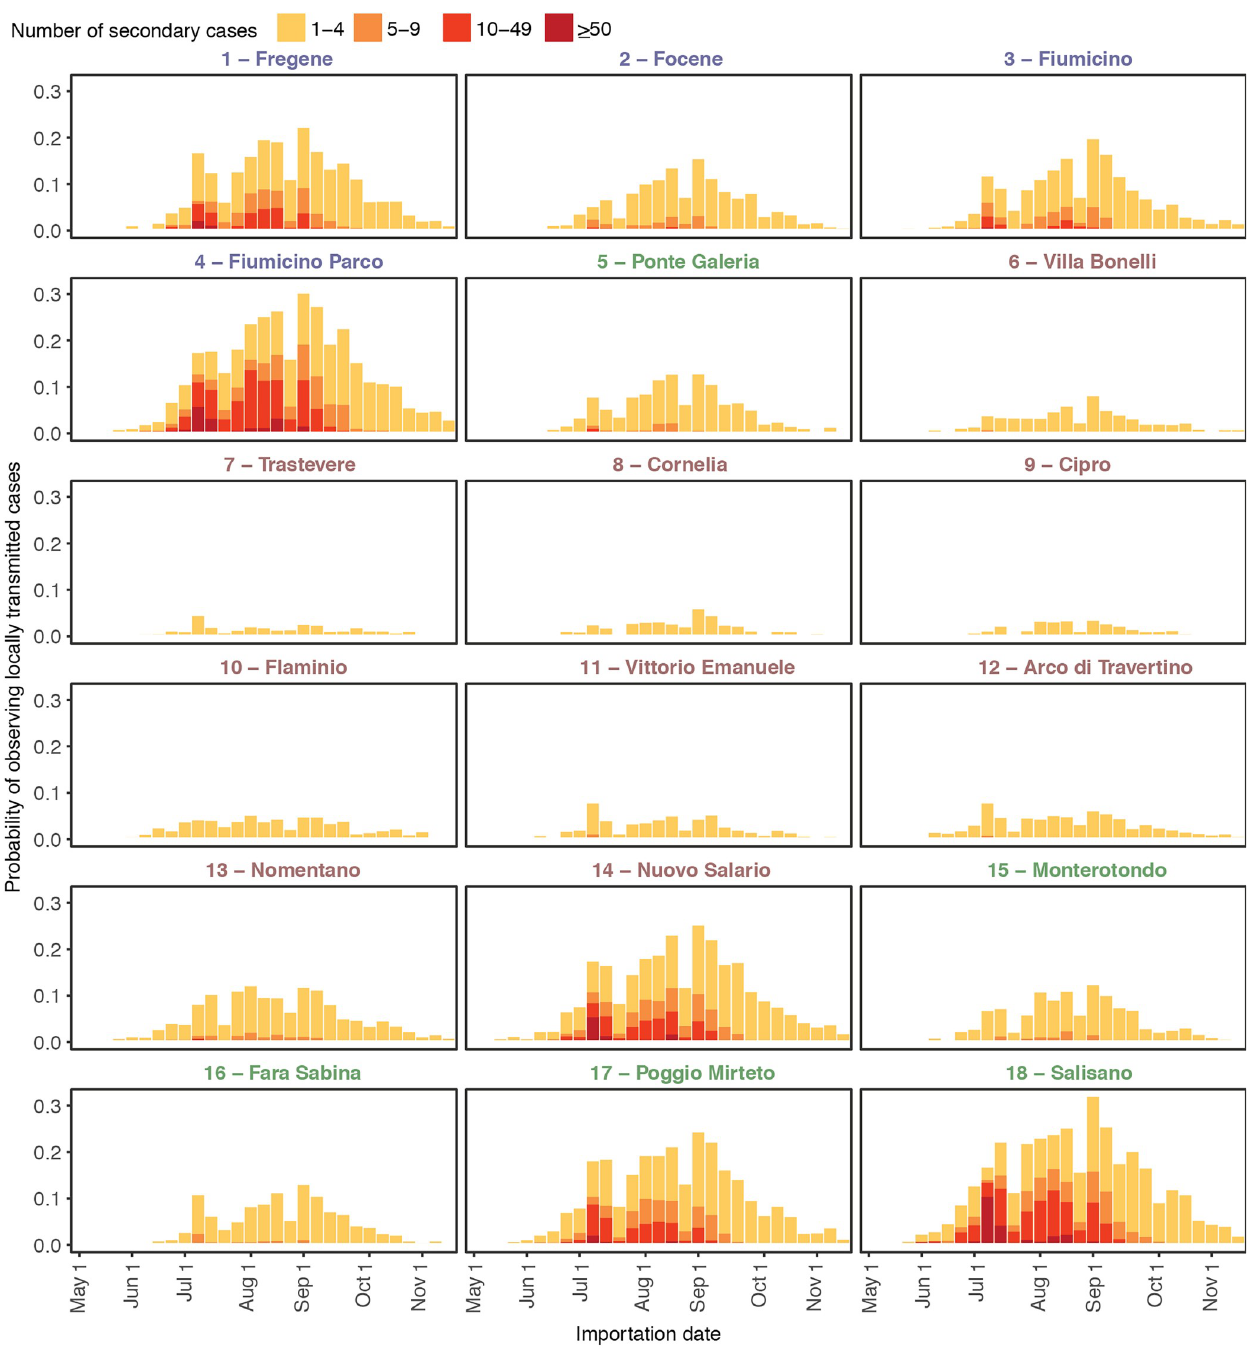
Fig 1. Autochthonous symptomatic YF cases. Probability of autochthonous symptomatic YF cases estimated by the model in 18 sites in Lazio region (Italy), conditional to the introduction of a single imported case at different times of the year and disaggregated by number of secondary cases. Font colors for site IDs represent the geographic classification of the site. Blue: coastal, red: urban, green: rural. YF, yellow fever.